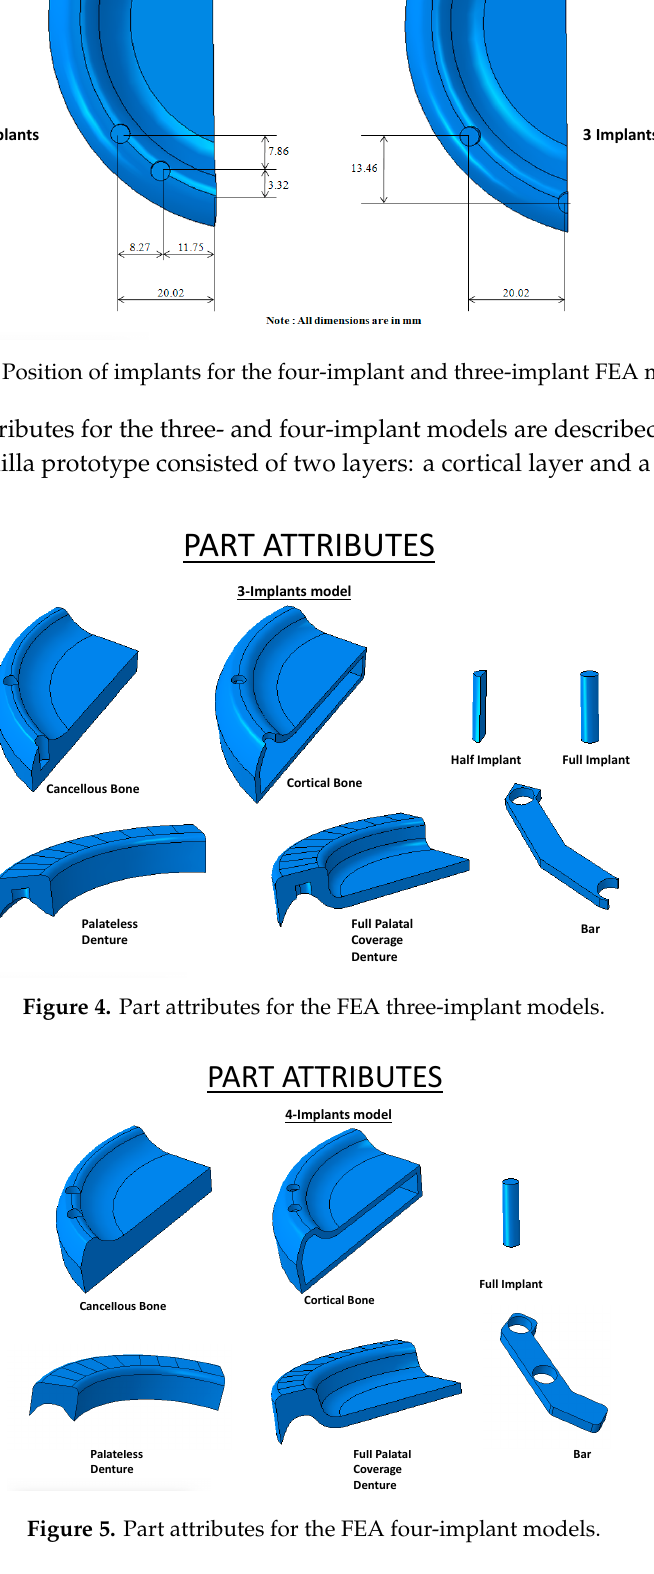
Figure 5. Part attributes for the FEA four-implant models.